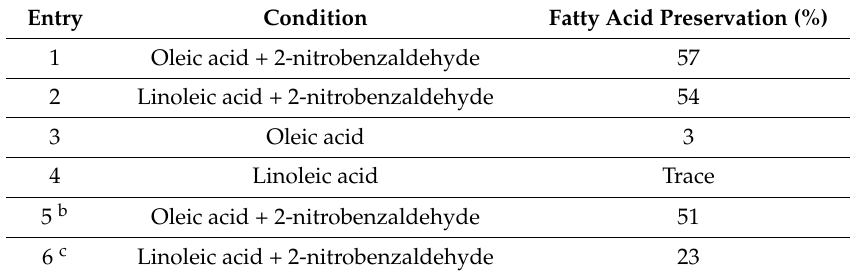
Table 2. Effect of 2-nitrobenzaldehyde on the preservation of unsaturated fatty acids from photooxidation a